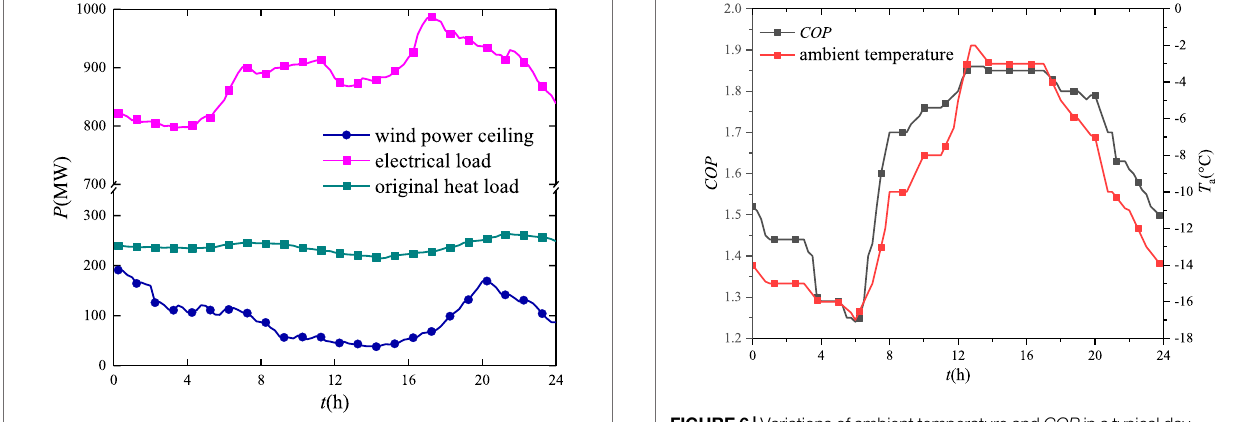
FIGURE 5 | Variations of electrical and heat loads and the wind power ceiling in a typical day.